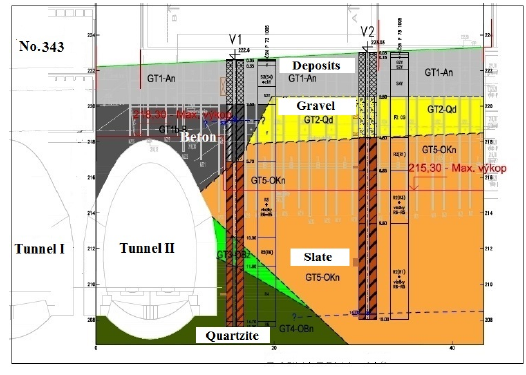
Figure 6. Geological profile 1 – 1’ ([4] –